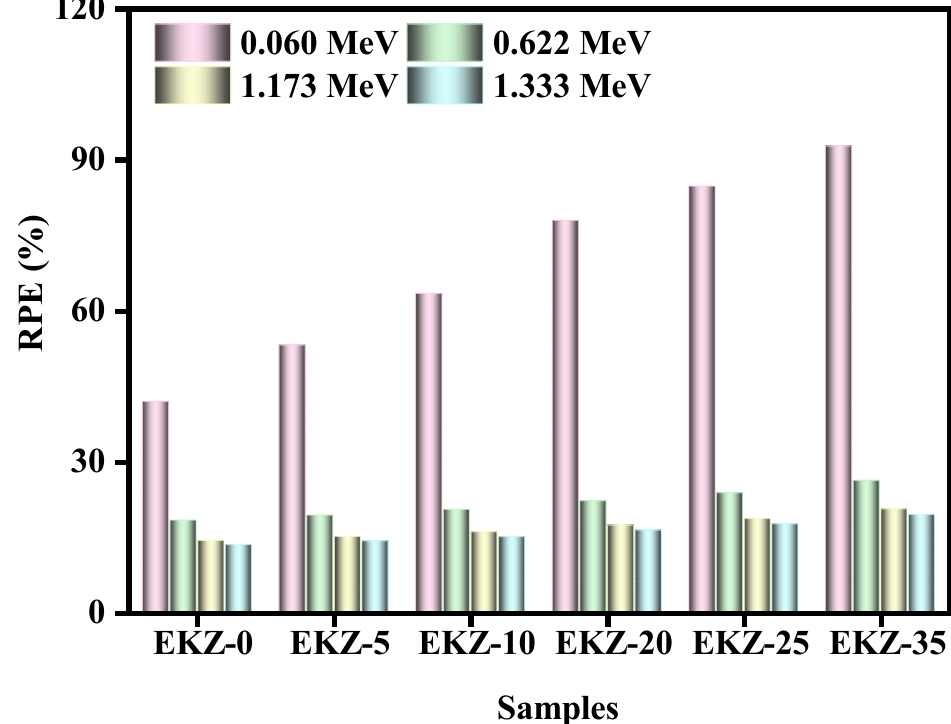
Figure 9. The RPE of EKZ samples as a function of photon energy.